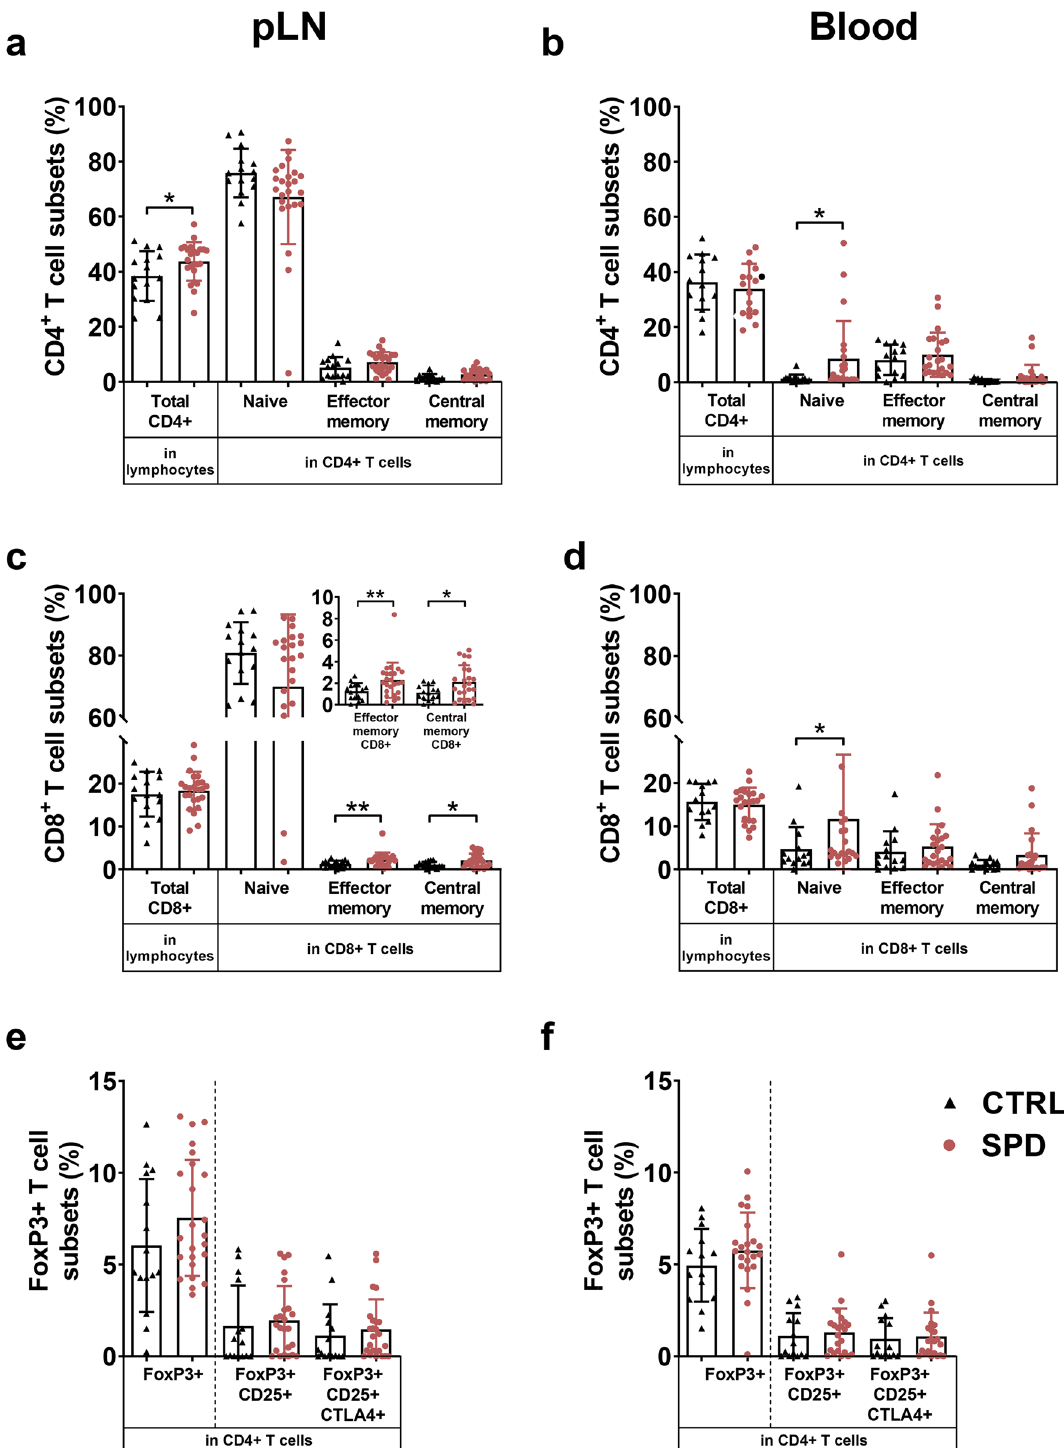
Figure 6. Daily oral spermidine treatment increased the proportion of CD8+ T-cell subsets in female diabetic mice. Total CD4+ T-cells, naïve CD4+ T-cells, effector memory CD4+ T-cells and central memory CD4+ T-cells in ( a ) pLN and ( b ) blood, total CD8+ T-cells, naïve CD8+ T-cells, effector memory CD8+ T-cells and central memory CD8+ T-cells in ( c ) pLN and ( d ) blood and FoxP3+ T-cells, FoxP3+ CD25+ Tregs, FoxP3+ CD25+ CTLA4+ Tregs in ( e ) pLN and ( f ) blood were examined. Black triangles show diabetic ctrl mice; for pLN (n = 15), for blood (n = 14) and red circles show diabetic spd mice; for pLN (n = 24), for blood (n = 22). Data is shown as mean ± SD. Mann–Whitney U test or unpaired Student’s t -test was used as statistical analysis to compare ctrl and spd mice . p * < 0.05, p ** <